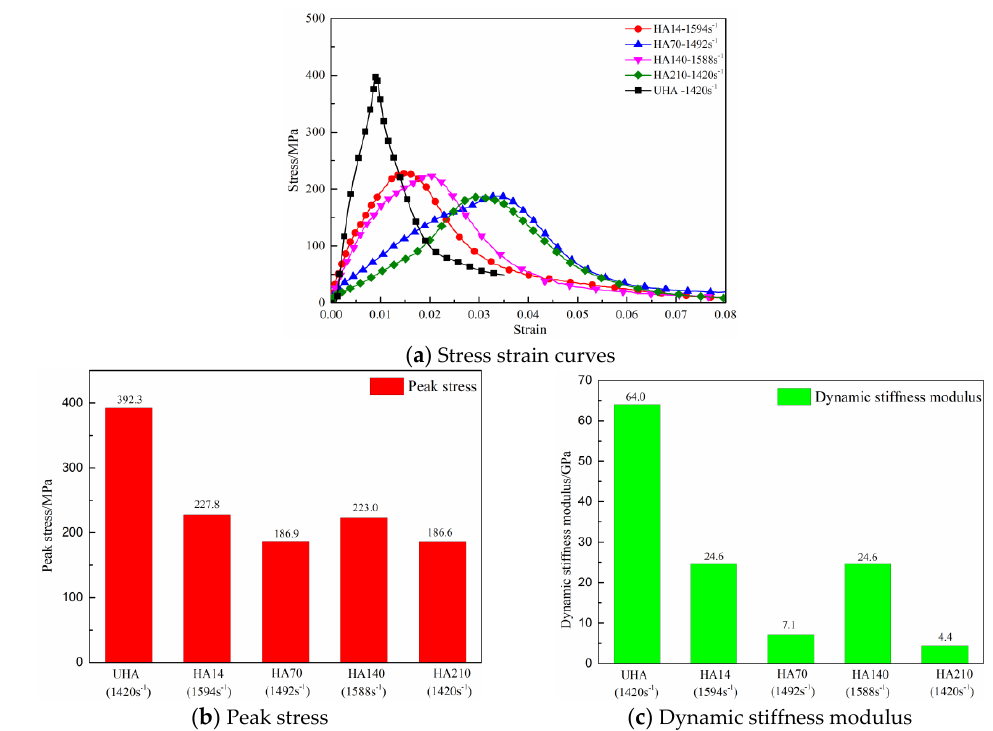
Figure 17. The e ff ect of cyclic hygrothermal aging on the dynamic compressive properties under Figure 17. The effect of cyclic hygrothermal aging on the dynamic compressive properties under 1400~1600 s − 1 , ( a ) Stress strain curves, ( b ) Peak stress, ( c ) Dynamic sti ff ness modulus.